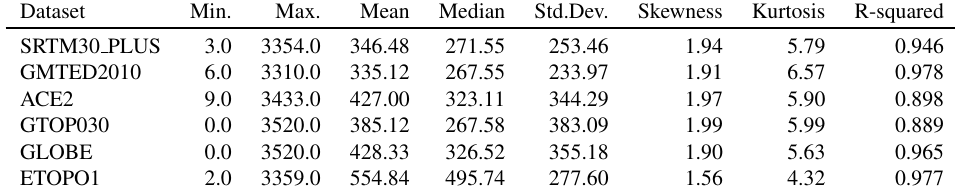
Table 1: Descriptive statistics of differences between altitudes of ultra prominent peaks and elevation of analysed GDEMs.